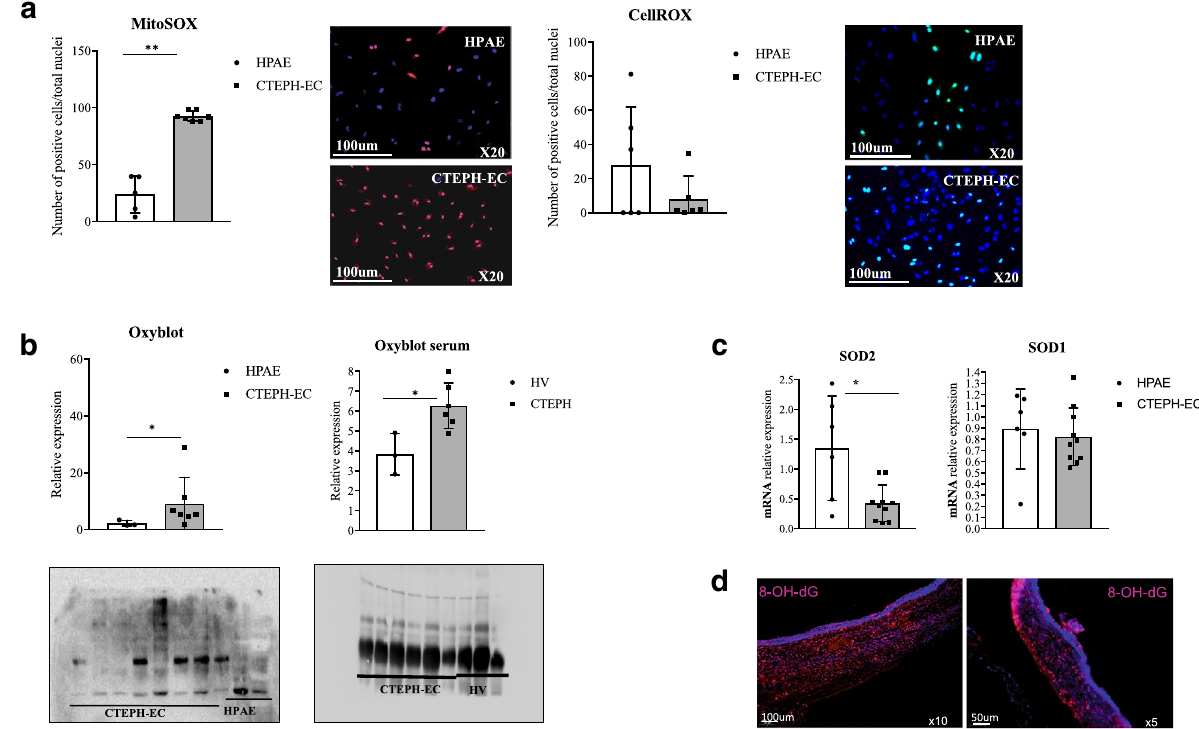
Figure 8. Oxidative stress in CTEPH-EC. ( a ) ROS levels in CTEPH-EC and HPAE were visualized by fluorogenic dye MitoSOX (red) n = 5 HPAE, n = 7 CTEPH-EC independent experiments, p < 0.01**, Mann– Whitney U test, values expressed as mean ± SD and CellROX (green) n = 6 HPAE, n = 6 CTEPH-EC, p > 0.05. ( b ) Oxidation status of proteins in CTEPH-EC, HPAE, patient serum and serum from healthy volunteers. n = 3 HPAE, n = 7 CTEPH-EC; n = 3 HPAE, n = 6 HV, p < 0.05*, Mann–Whitney U test, values expressed as mean ± SD. The intensity of the bands was quantified using Image Lab software (Biorad laboratories), version 6.1.0 build7, http:// www. biorad. com. ( c ) mRNA expression of SOD1 and SOD2 in CTEPH-EC and HPAE. Values expressed as mean ± SD, n = 6 HPAE, n = 10 CTEPH-EC independent experiments performed in triplicate, p < 0.05*, Mann–Whitney U test. ( d ) Staining of DNA damage induced by oxidative stress in PEA specimen using 8-hydroxy-2 ′ -deoxyguanosine (8-OHdG). Statistical analysis was performed with GraphPad Prism 7 software, version 7.0e, serial number:GP7-0633739-R###-#####, https:// www. graph pad.